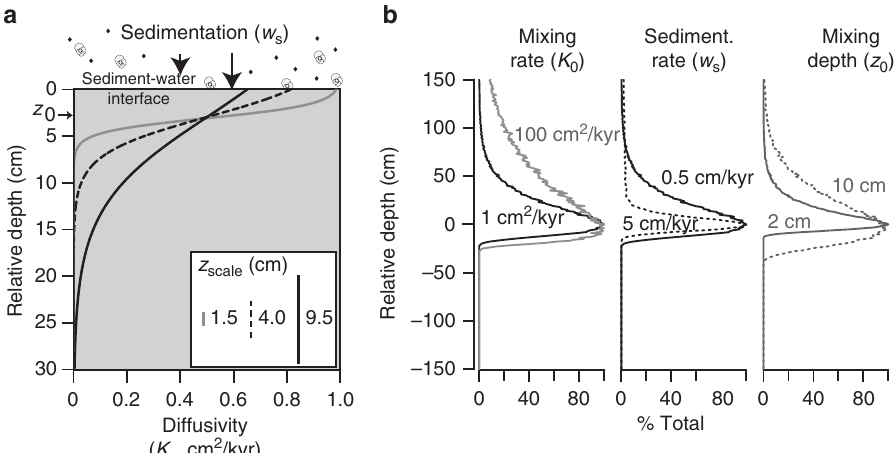
Fig. 3 The Lagrangian sediment-mixing model and model behavior. a Lagrangian mixing model schematic after ref. 16 . The three curves show the effect of varying z scale on the depth- dependent diffusivity ( K v ) – or mixing intensity. z 0 is held constant in these three scenarios and shown at the left with a small arrow . Other factors modifying the average mixing depth of particles is K 0 (maximum vertical diffusivity) and sedimentation rate ( w s ). The effect of these factors on the average mixing pro fi le of a point event is shown in b , a simpli fi ed version of a fi gure from ref.